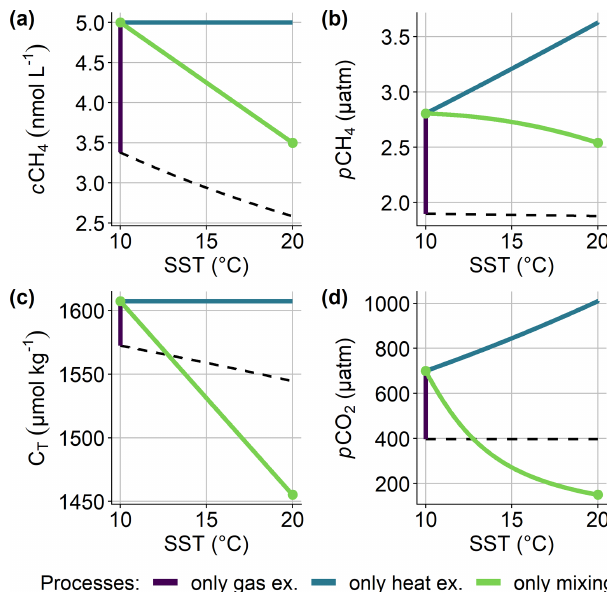
Figure 8. Theoretical relaxation curves of surface trace gas and temperature signals caused by upwelling. We calculated all graphs based on the processes (i) air–sea gas exchange, (ii) air–sea heat exchange, and (iii) mixing with a typical water mass with pre- upwelling conditions, with only one process considered at a time, starting at the point where the three lines intersect. Bold green points highlight the mixing endmembers. Dashed black lines indi- cate atmospheric-equilibrium conditions for the respective trace gas (397ppm of CO 2 , 1920ppb of CH 4 ). Mixing lines were calculated for (a) c CH 4 using linear interpolation between endmembers (con- servative behaviour), (b) p CH 4 from c CH 4 and SST, (c) C T using linear interpolation between endmembers whose C T was calculated from A T and p CO 2 (conservative behaviour), and (d) p CO 2 from C T and A T . See Sect. B1 for details concerning calculation param-